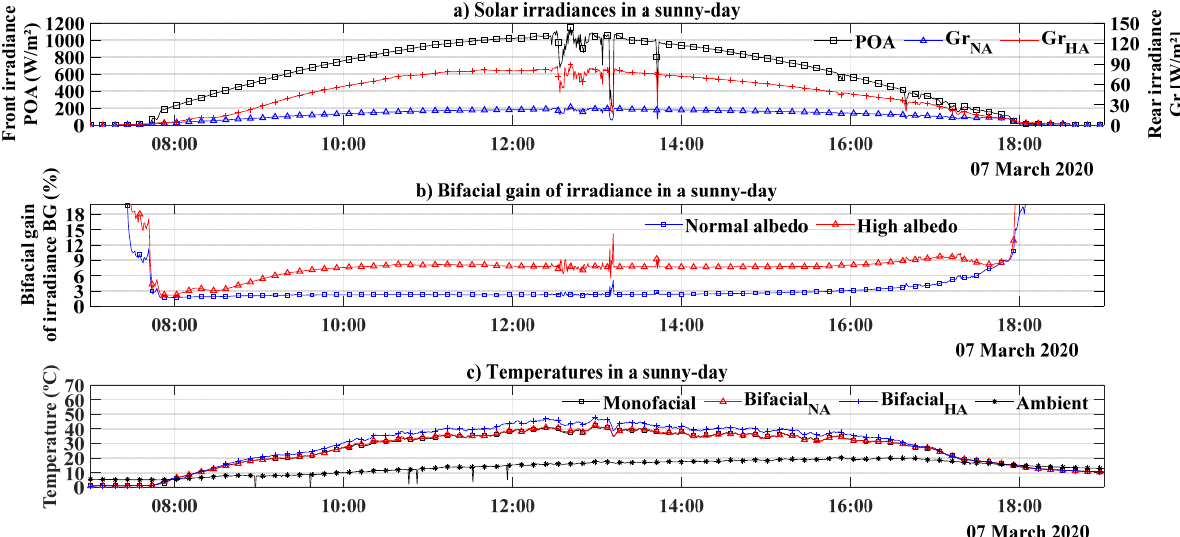
Figure 5. Measured weather parameters under clear sky. ( a ) Front and rear solar irradiance. ( b ) Bifacial gain for normal and high albedos. ( c ) Operating and ambient temperatures.